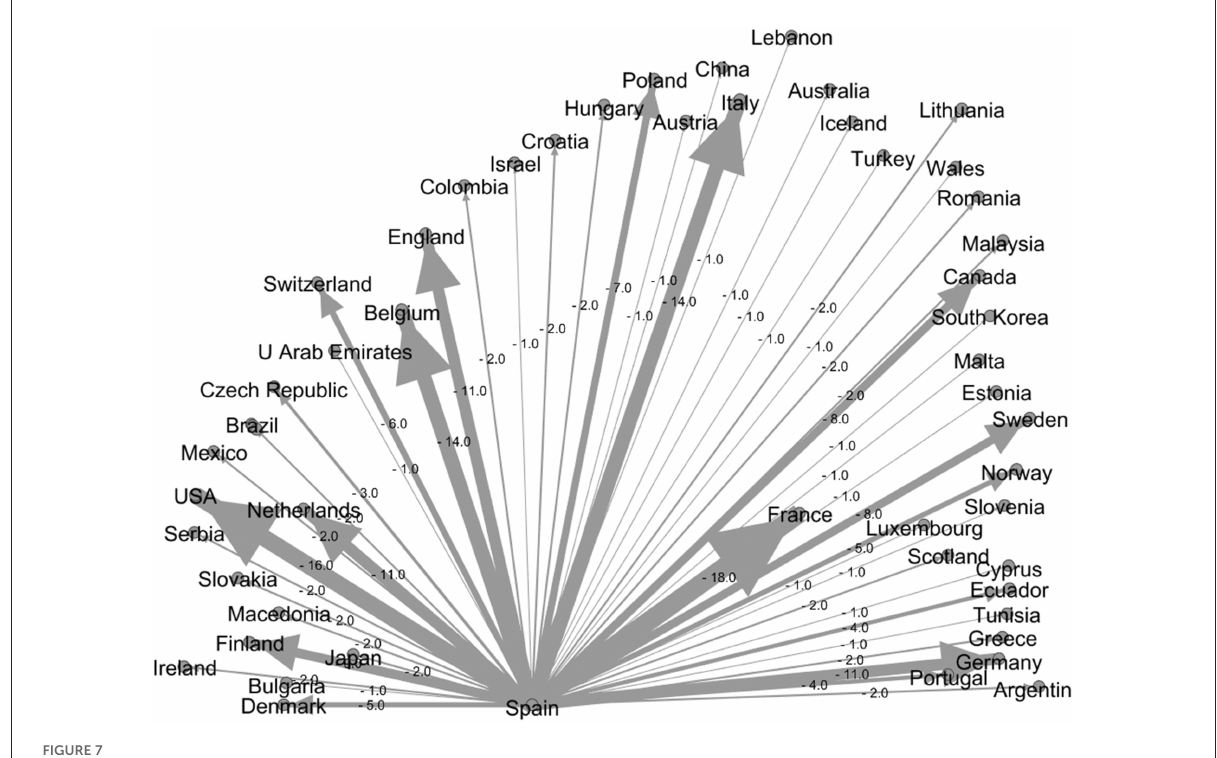
FIGURE7 Spain cooperation network with other countries.